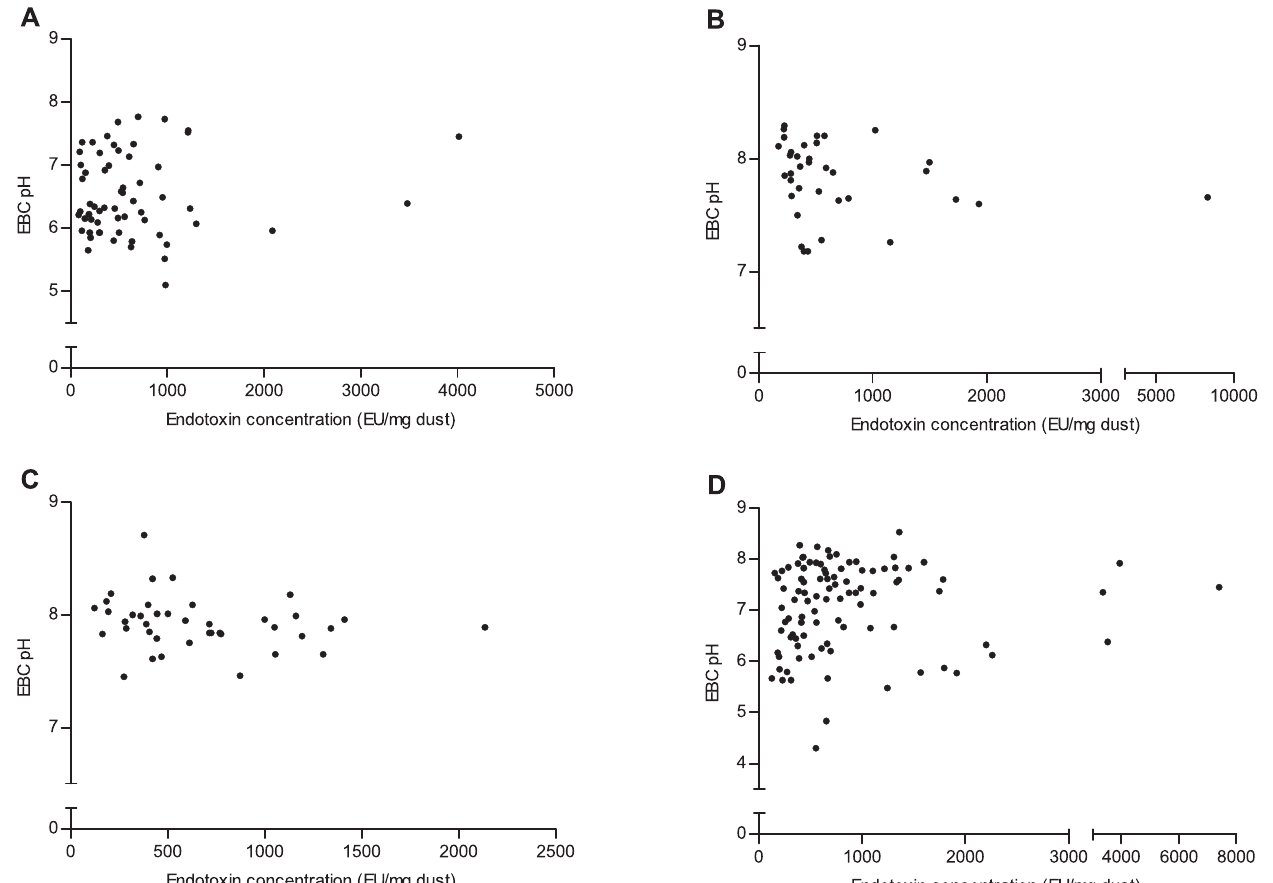
Figure 6. Associations between endotoxin concentrations and EBC pH values in children. (A) asthma group; (B) allergic rhinitis group; (C) AS + AR group; (D) control